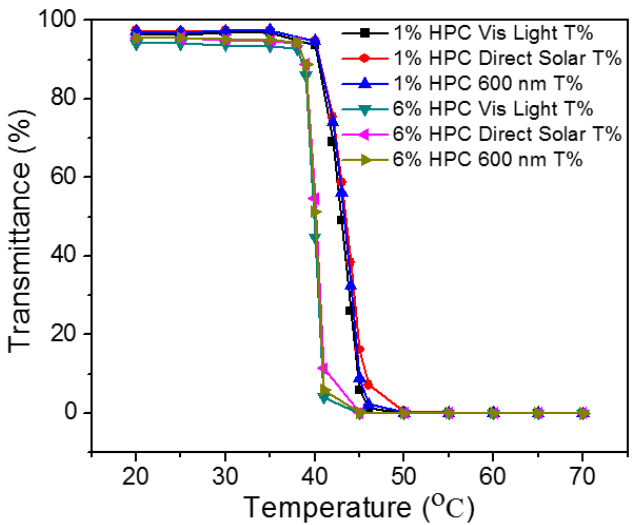
Figure 5. UV-Vis spectra showing transmittance of aqueous 1 wt. % and 6 wt. % HPC at 600 nm, averaged over 430 nm to 780 nm (Vis Light T%) and averaged over 440 nm to 950 nm (Direct Solar T%).